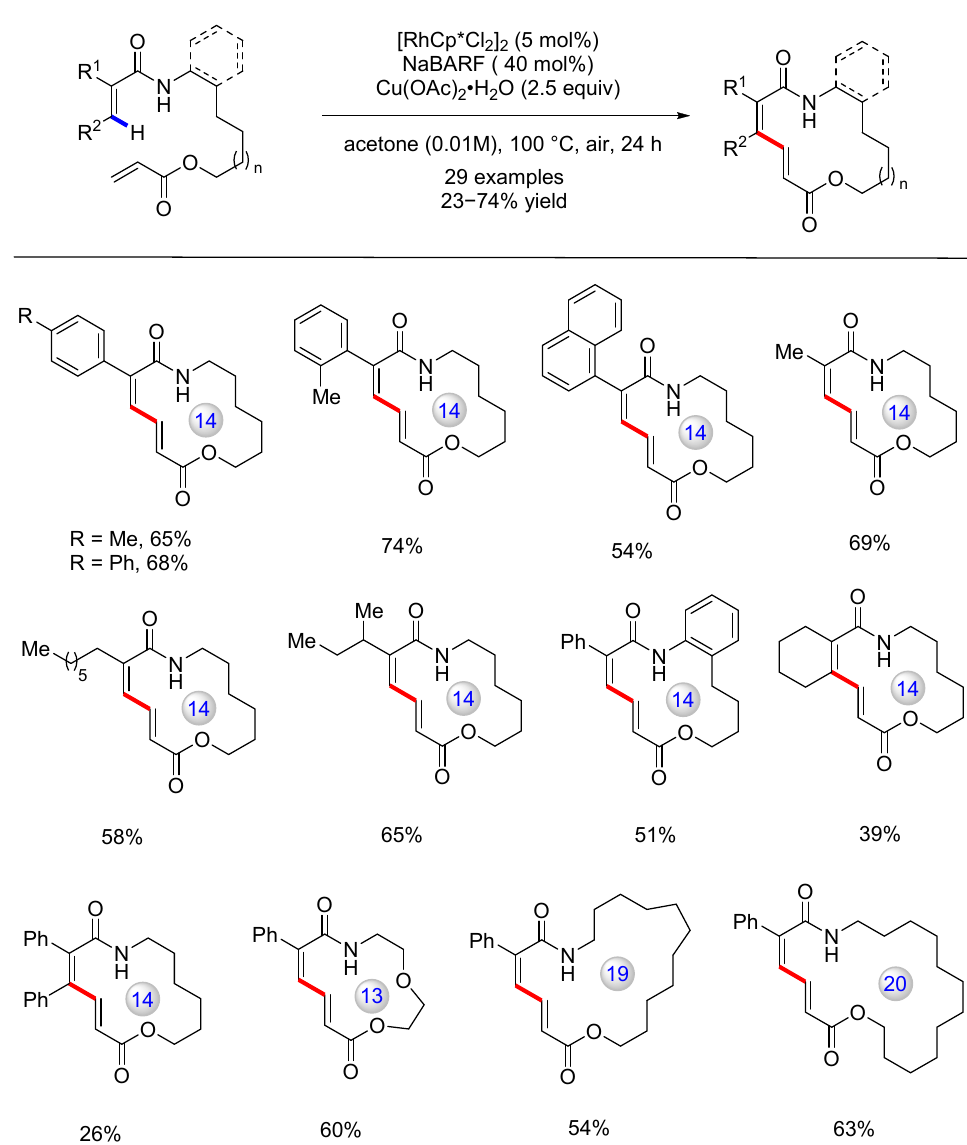
Figure 3. Macrolide synthesis via Cp*Rh(III) ‐ catalyzed intramolecular oxidative cross ‐ coupling of alkenes [56].